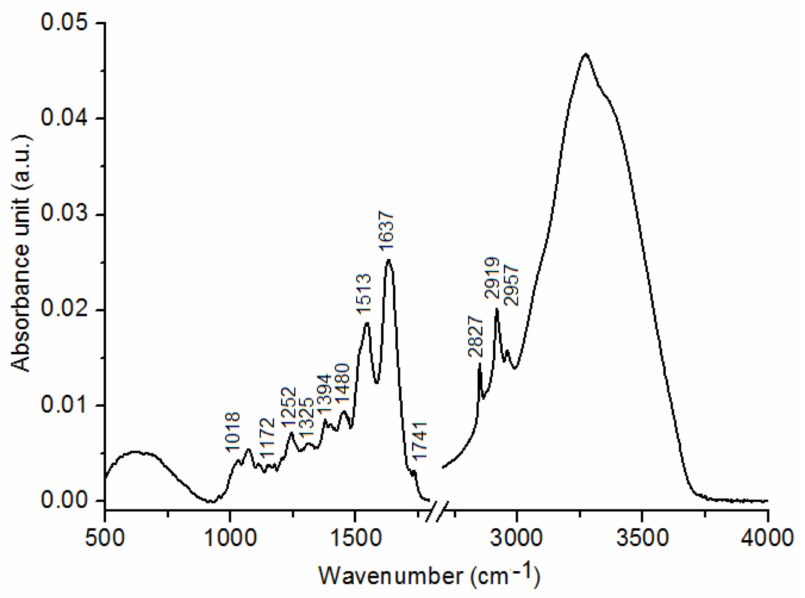
Figure 1. Fourier transform infrared (FTIR) spectrum of C. tujafilina with marked analyzed functional groups.